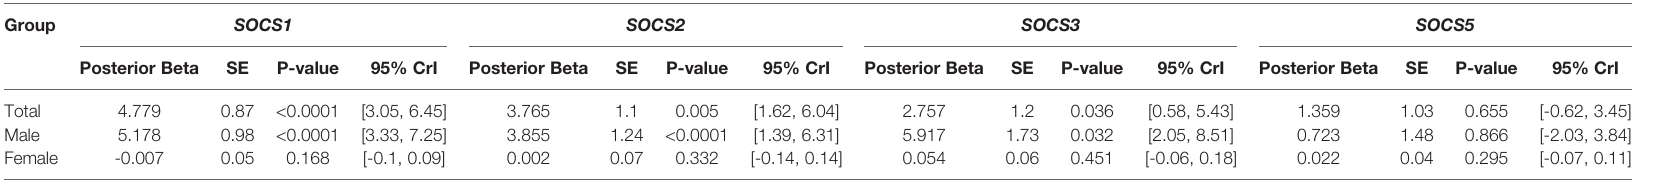
TABLE 5 | Relative expression of SOCS genes in AIDP cases versus